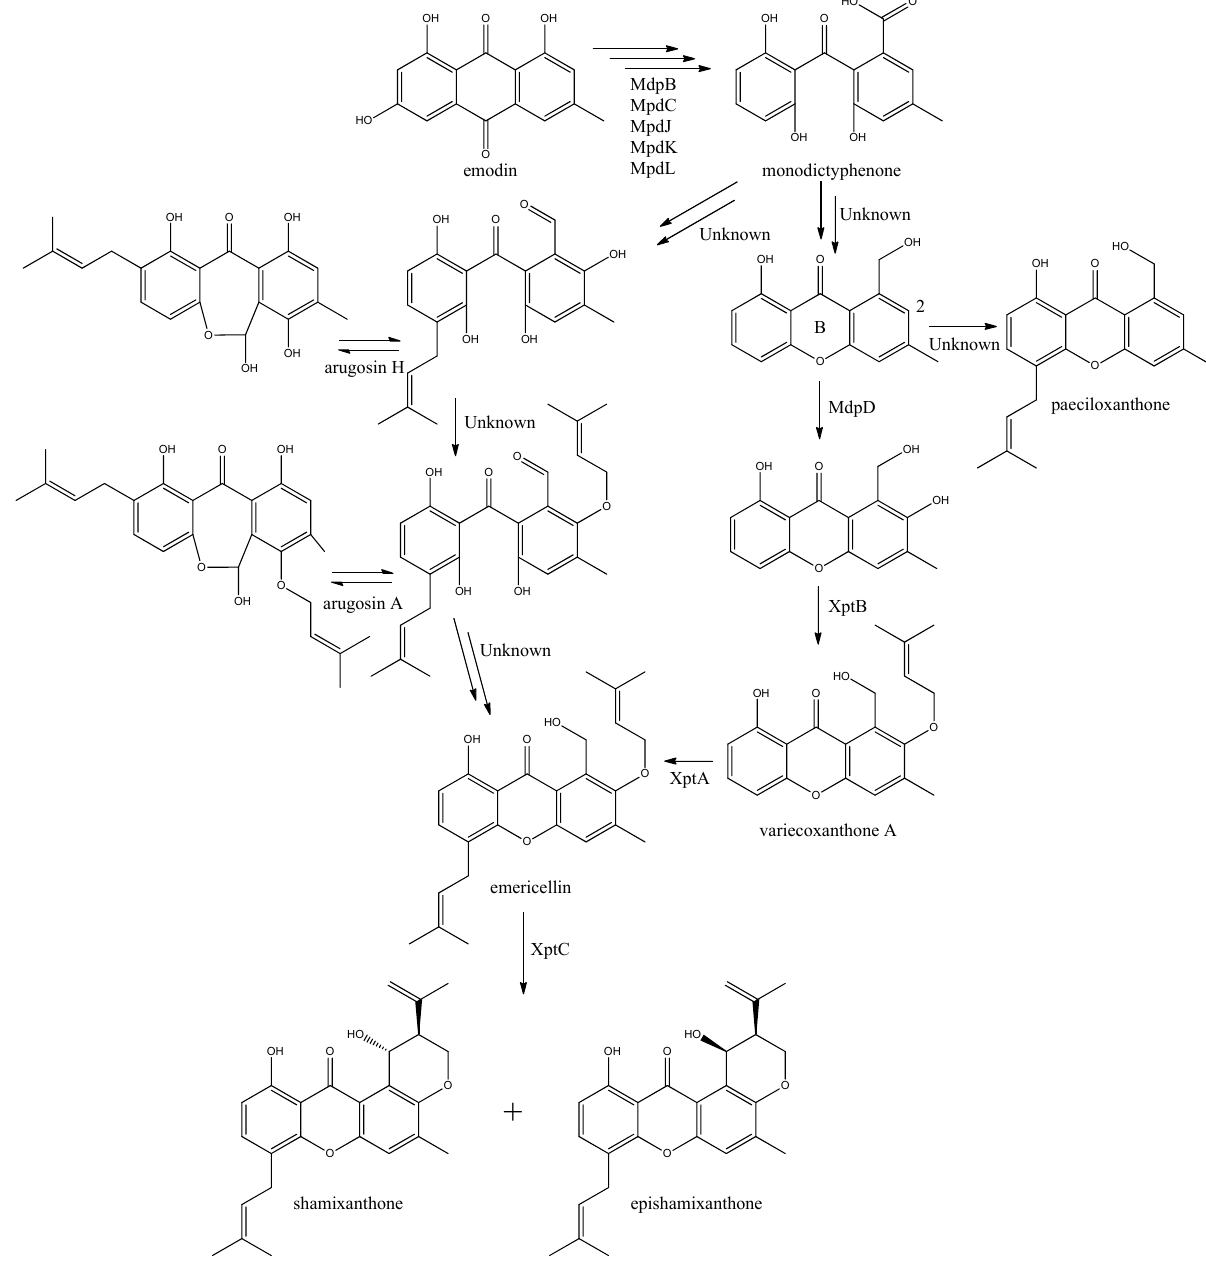
Figure 10. Suggested biosynthesis of the shamixanthons from emodin. Multiple arrows indicate that the number of enzymatic steps are